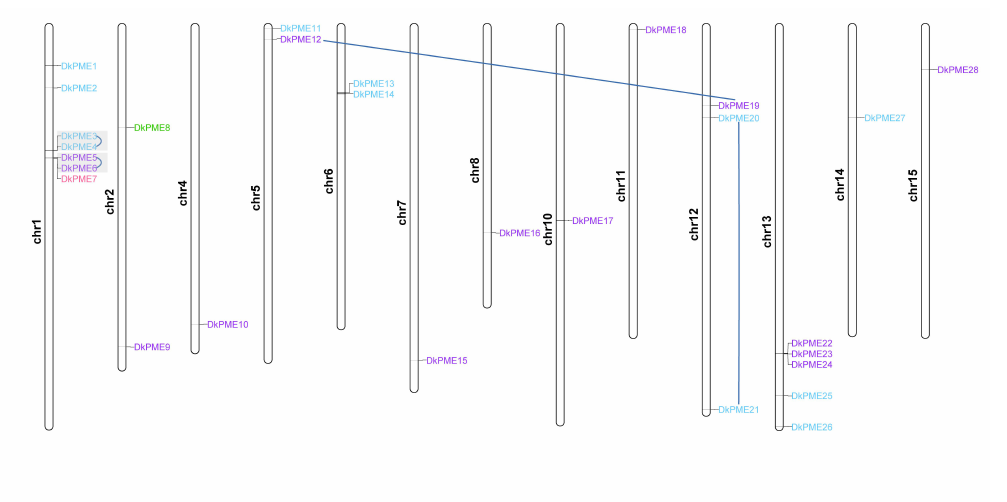
Figure 4. Chromosome location of DkPME genes in D. kaki . Genes of different groups are expressed in different colors. Darkblue lines showed fragment duplication events, and gray boxes presented tandem duplication events.